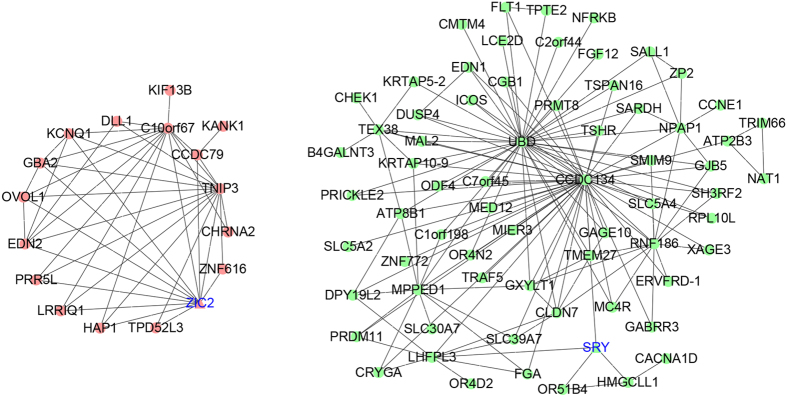
Intra-modular connectivity of the green and red modules.Green nodes denote genes in the green module; red nodes denote red module genes. Triangle nodes with blue labels are transcriptional factors.